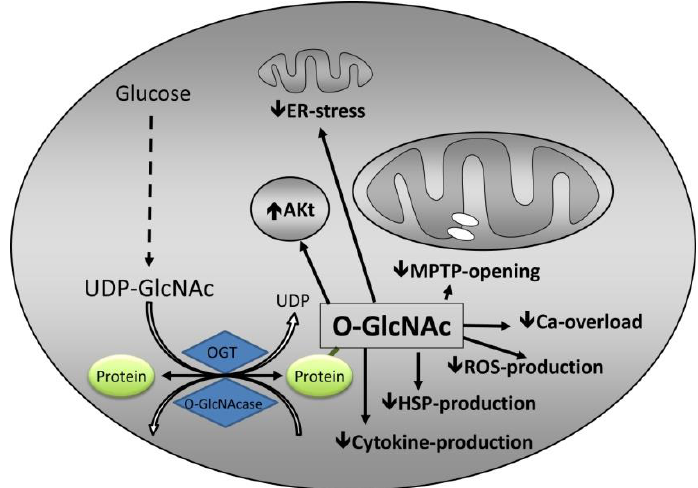
Figure 3. Summary of potential mechanisms by which O-GlcNAc confers protection. The mechanisms involve attenuation of endoplasmic reticulum (ER) stress, interaction with established cardioprotective pathways, predominantly Akt, inhibition of mitochondrial permeability transition pore (MPTP), attenuation of calcium overload, reactive oxygen species (ROS), heat shock protein (HSP), and cytokine production that reduce systemic inflammatory response. Other abbreviations as in Figure 1.